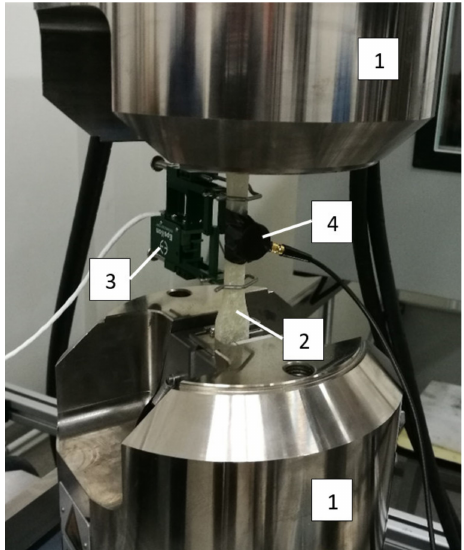
Figure 4. View of specimen fixed into tensile testing machine grips: 1–tensile testing machine grips, 2–specimen, 3–extensometer, 4–AE sensor [30].